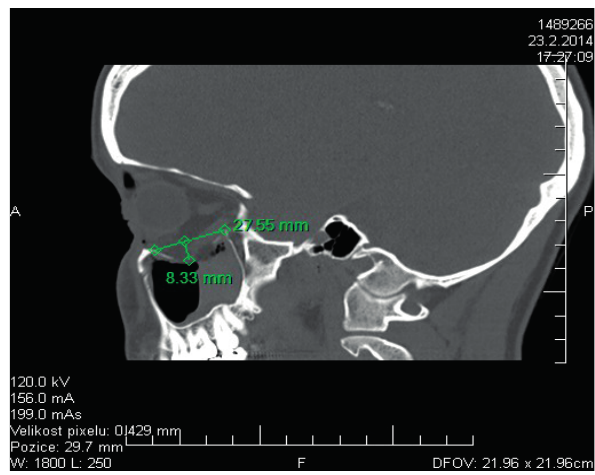
Fig. 3. Measurement through sagittal section.